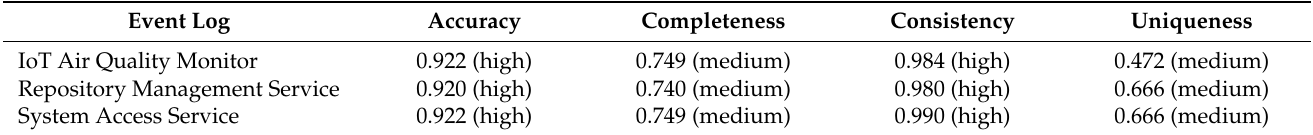
Table 2. Quality metrics calculated for each of the event logs